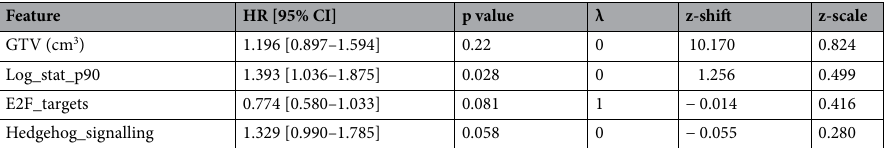
Table 4. Information on features of the multivariable Cox regression model integrating CT radiomics features and the two selected metagenes: hazard ratio (HR) (95% CI) along with model p values, Yeo–Johnson parameter (λ) and transformation parameters for z-transform (z-shift and